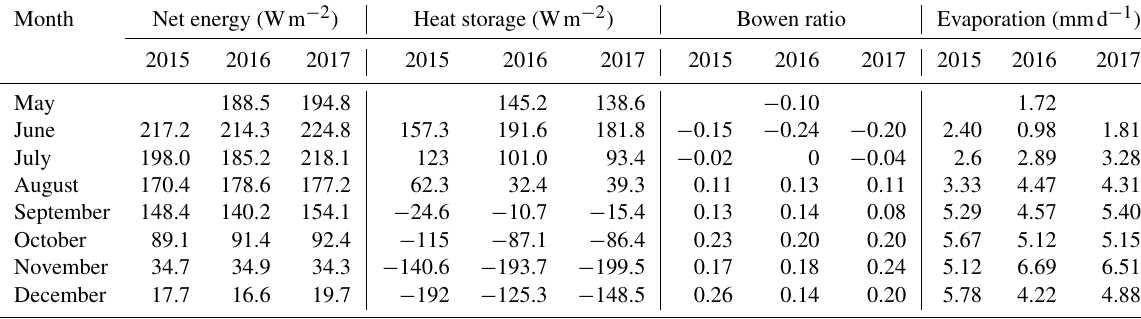
Figure 3. Depth–time diagram of isotherm ( ◦ C) in Paiku Co’s southern ( a , 42m in depth) and northern ( b , 72m in depth) basins between June 2015 and May 2018. Table 2. Monthly net radiation, total lake heat storage, Bowen ratio, and lake evaporation between 2015 and 2017.